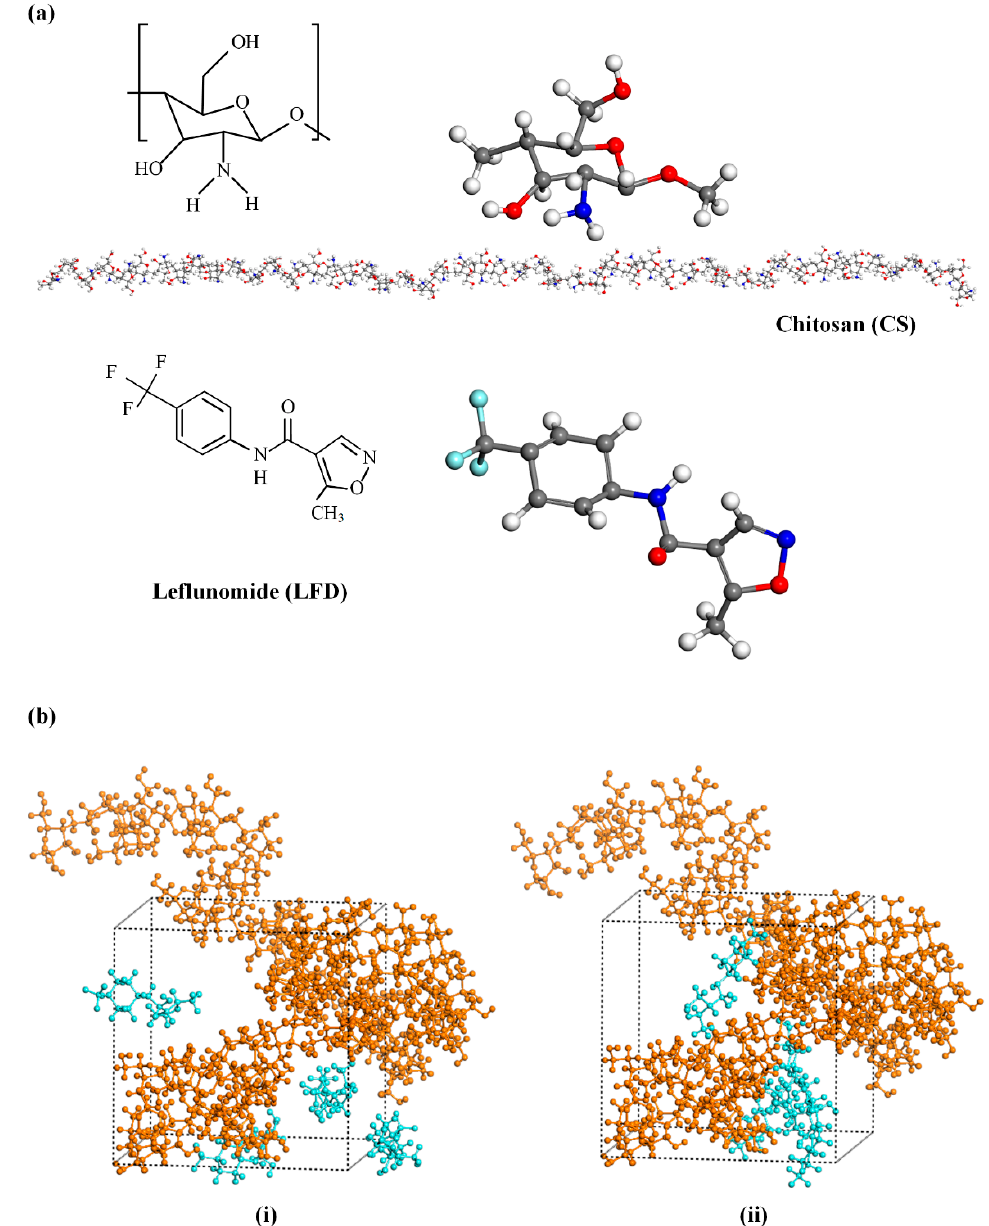
Figure 3. ( a ) Initial MD chemical structures of the CS polymer with 50 monomers and the LFD drug molecule (carbon atoms are depicted with grey, hydrogen with white, nitrogen with blue, oxygen with red, and fluoride with blue). ( b ) MD simulation boxes for LFD (blue color) and CS (orange color) mixture, before ( i ) and after ( ii ) the adoption of the multistep equilibration protocol.